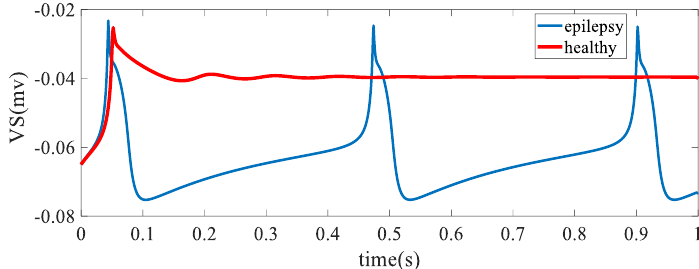
Figure 2. Comparison between epilepsy state and healthy state.